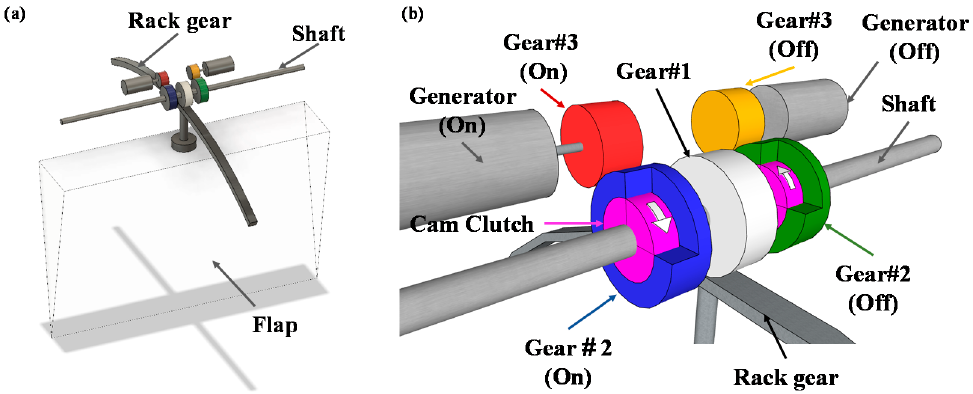
Figure 4. Simplified power take-o ff system with the flap: ( a ) full view and ( b ) detailed view. Gear 1 is fixed to the shaft and meshes with the rack gear, which is fixed to the upper part of the flap. When the flap reciprocates owing to the waves, the meshing of gear 1 with the rack gear shaft is rotated with the shaft. On the shaft, two cam clutches that rotate in only one direction are fixed. Each cam clutch rotates according to a ratchet mechanism when the direction of the white arrow (shown in Figure 4b) and that of the shaft rotation match. However, when the rotary shaft rotates in a direction opposite to the direction of the arrow, the cam clutch shifts to idling. The cam clutches are installed so that the e ff ective rotation is in the opposite direction. Gear 2 is sandwiched and fixed to the outside of each cam clutch. When the cam clutch rotates, gear 2 rotates, and the meshing of gear 3 with gear 2 also rotates simultaneously. Gear 3 is connected to a rotary generator, and the generator operates when gear 3 rotates. The detailed specifications of the gear units are presented in Table 2.